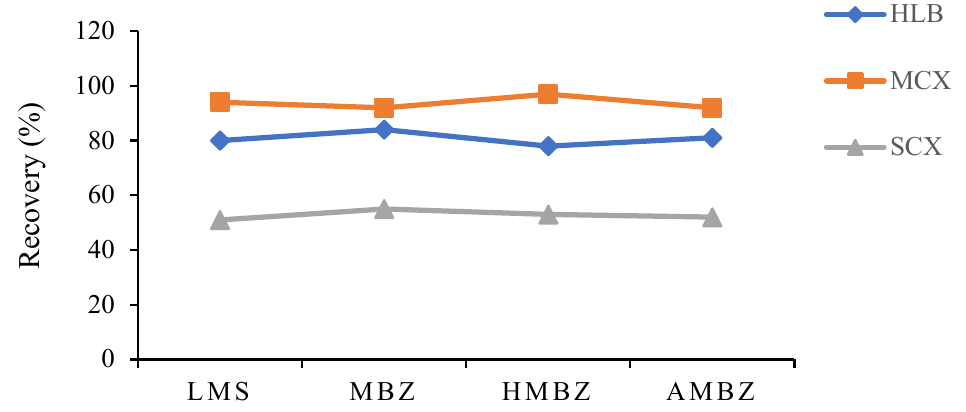
Figure 3. Comparison of the recovery rates of HLB, MCX, and SCX with different SPE cartridges.